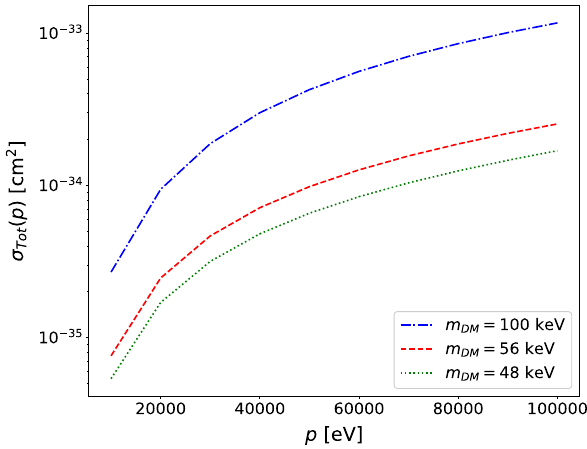
Fig. 3 Cross section integrated in solid angle as a function of the neu- trino initial momentum p for different values of m DM (see Eq. 8)